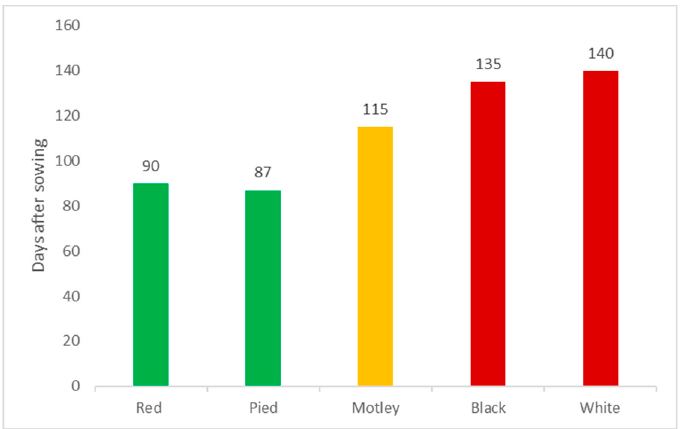
Figure 5. Maturity periods for the five bean varieties in 2018. White, pied, and red beans had significantly more stems per plant than black and motley beans (Figure 6). White, black, motley, red, and pied beans were progressively shorter. Overall yields were highest for motley beans, followed closely by black, red, and pied beans, while white beans had significantly lower yields than all other varieties (Figure 6). Motley beans had greater hundred seed weight than both white and red beans. White beans plants had the highest dry weight of all varieties (Figure 7).